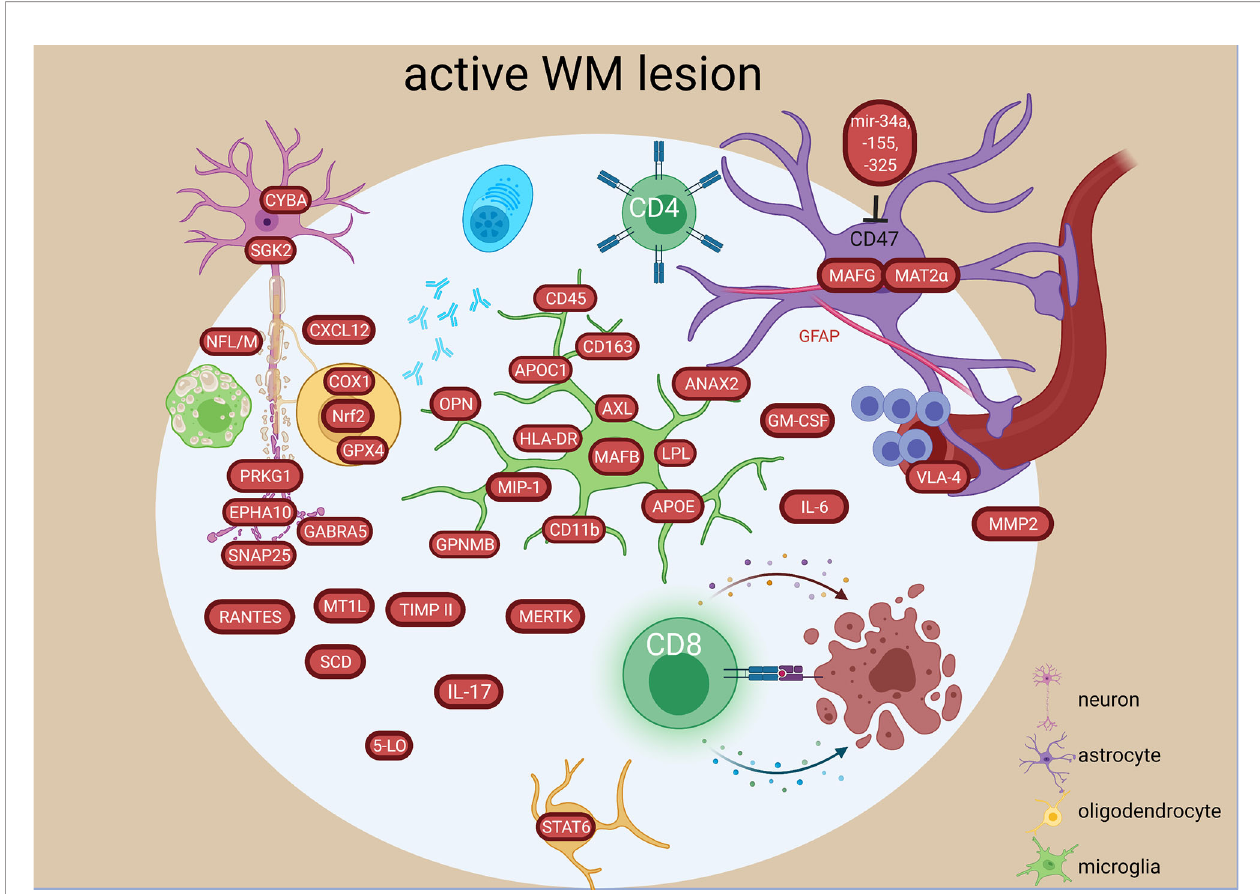
FIGURE 4 | Signature of active WM lesion in the MS brain based on transcriptome and proteome studies. In the active lesion, an increase in both innate and adaptive in fl ammatory responses are present characterized by different molecular components in resident and in fi ltrating cells. An oxidative stress and degenerative pro fi le especially in the oligodendrocytes and neurons have also been detected. The fi gure was created by compiling data from several articles, and therefore molecules may not be expressed at the same time. Created with